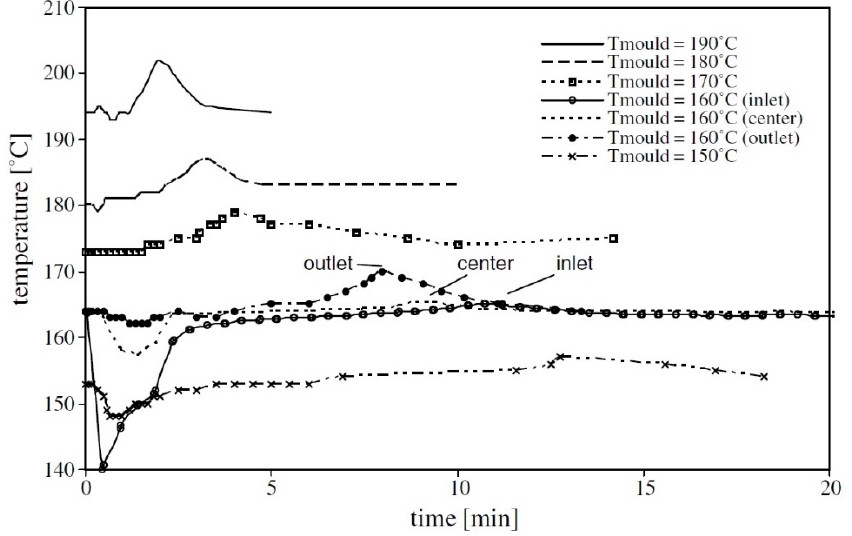
Figure 12. Temperature progression during processing APA-6 composites for various initial mold temperatures. At the start of the infusion, t = 0 s. Reprinted from Reference [44], under open-access license.